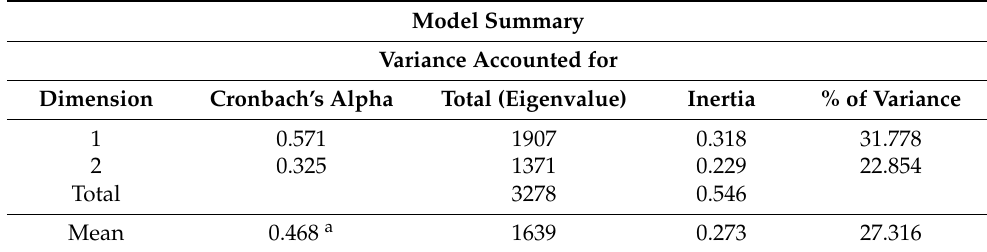
Table 2. Two-dimensional solution.